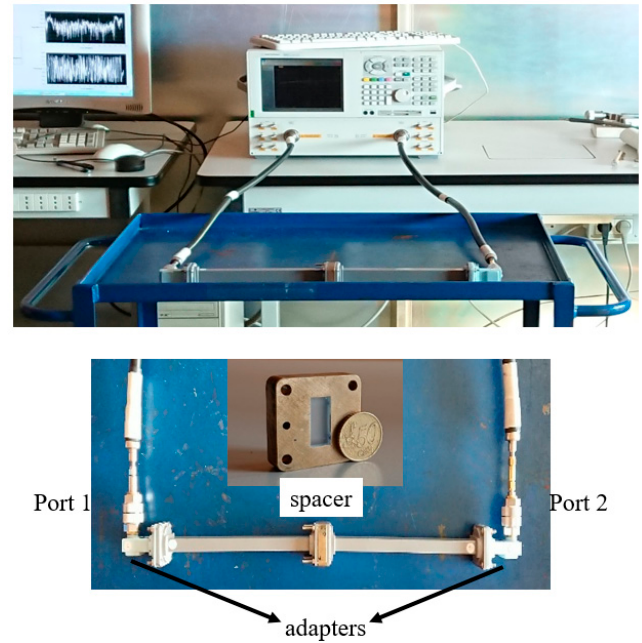
Figure 2. WR90 waveguide measurement set-up.